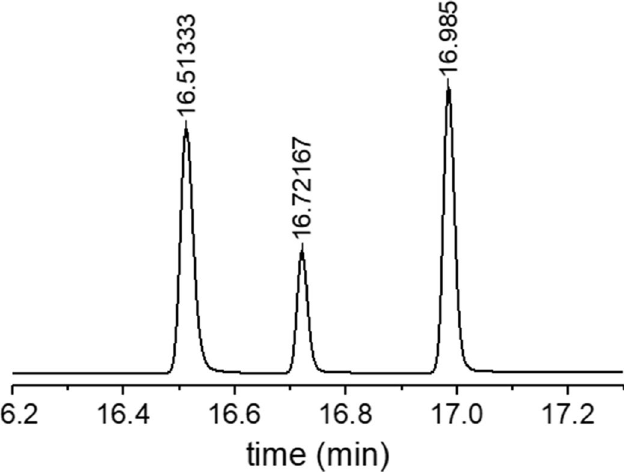
Figure 3. GC spectra measured by injection after 15 min from the start of measurement by loading in the GC specimen chamber. The results obtained after decompressing an EPDM sample (cylindrical shape, diameter: 4.1 mm, thickness: 2.6 mm) filled with HP hydrogen for 24 h in a container at 4.85 MPa. The GC signals of hydrogen, oxygen, and nitrogen molecules are shown from left to right. Oxygen and nitrogen signals come from the air not emitted by the rubber because of the contact with air environment during sample moving.